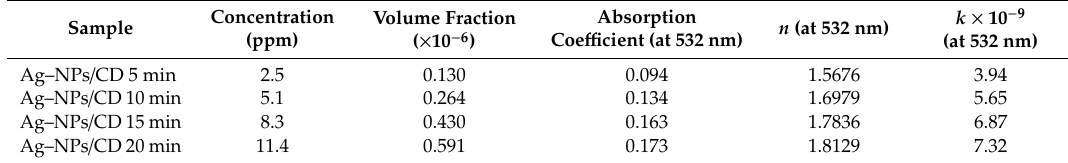
Table 1. Pertinent parameters of Ag–NPs / CD composite solution.